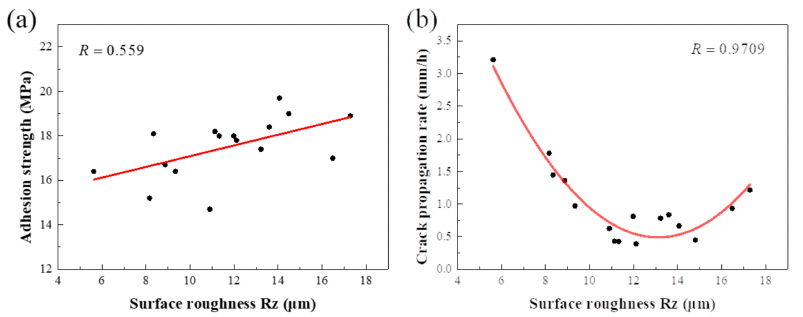
Figure 11. The fitting analysis results of surface roughness: ( a ) adhesion strength; ( b ) average rate of the corrosion crack